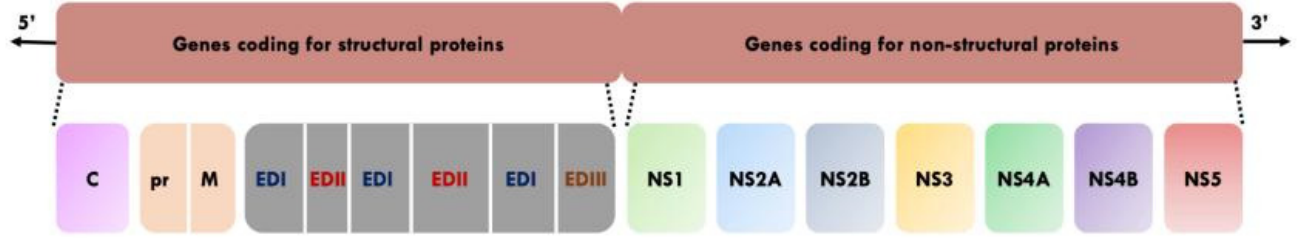
Figure 1. Genome organisation of YFV [2,7,8]. C: Capsid. pr: Precursor. M: Membrane. ED1: envelope domain I. EDII: Envelope domain II. EDIII: Envelope domain III. NS: Non-structural protein.